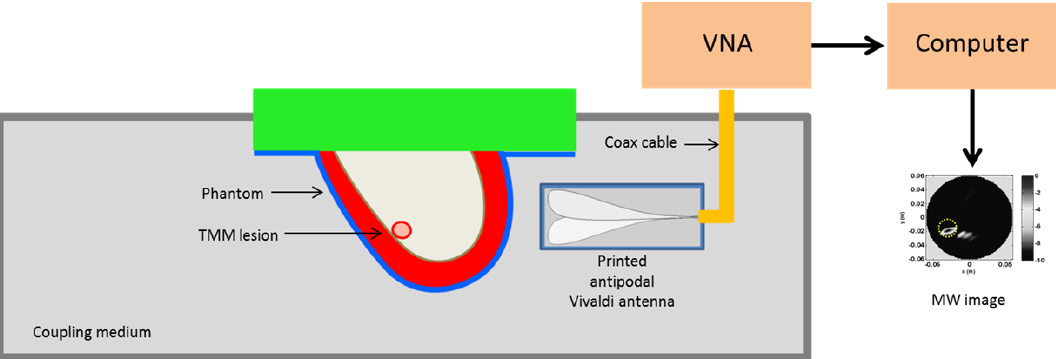
Figure 4. Schematic diagram showing the MBI scanning setup. The system antenna + phantom is immersed in a coupling medium. The antenna is connected to a Vector Network Analyzer (VNA) scanning the phantom at a fixed height in multimonostatic configuration. This allows collecting data for a single coronal